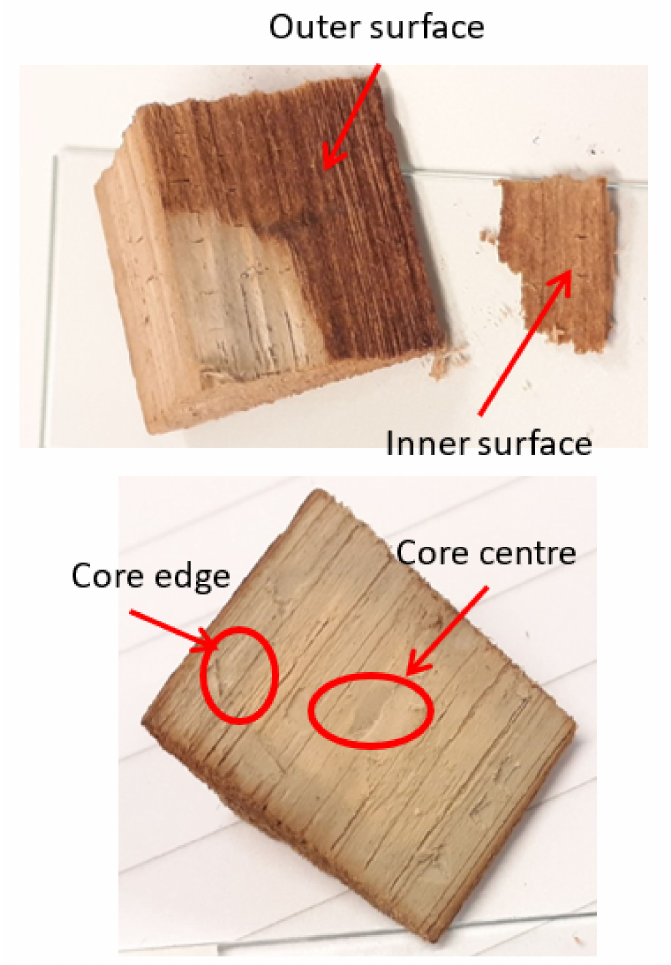
Figure 1. Areas sampled for infrared analyses: ‘outer surface’, ‘inner surface’, ‘core edge’ and ‘core centre. For Py-GC/MS, only ‘inner surface’ and ‘core centre’ were analysed. These depths were used to evaluate penetration of the